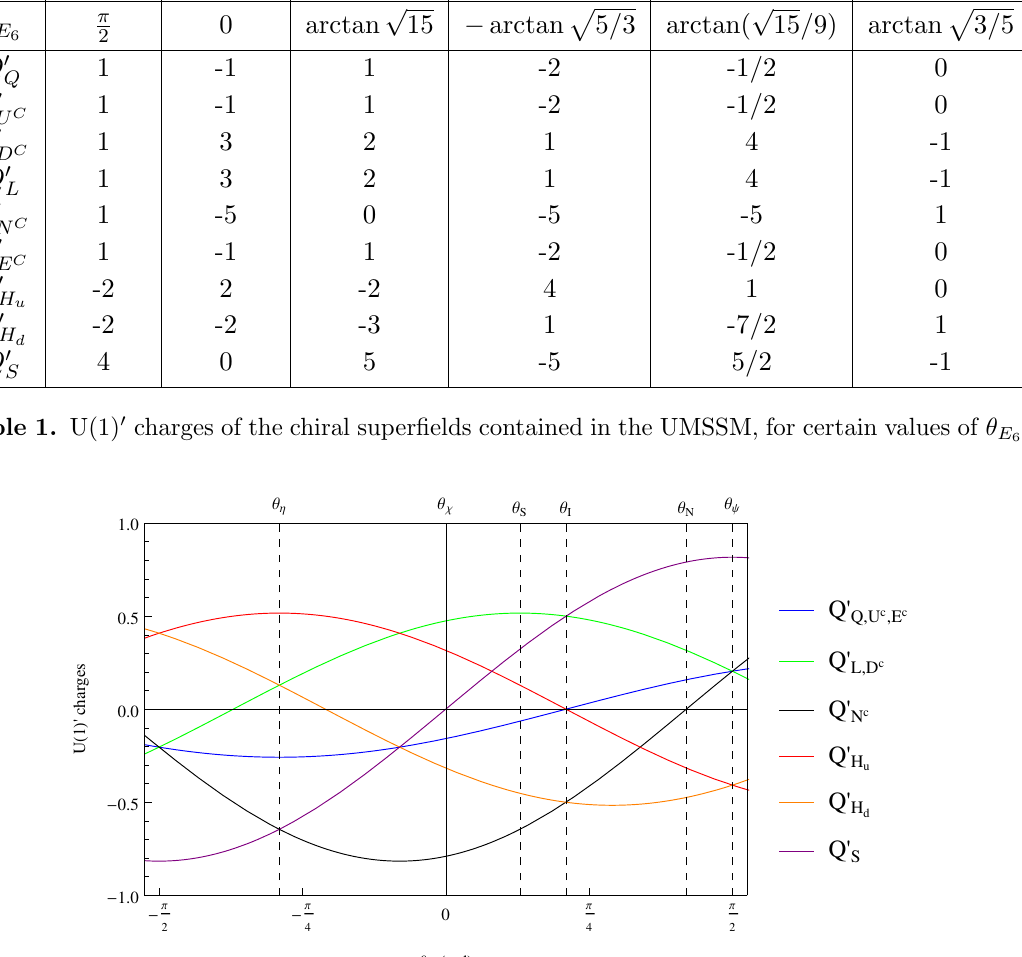
table 1. This model is not of interest to us, since the ~ (cid:23) R;i are then complete gauge sin-